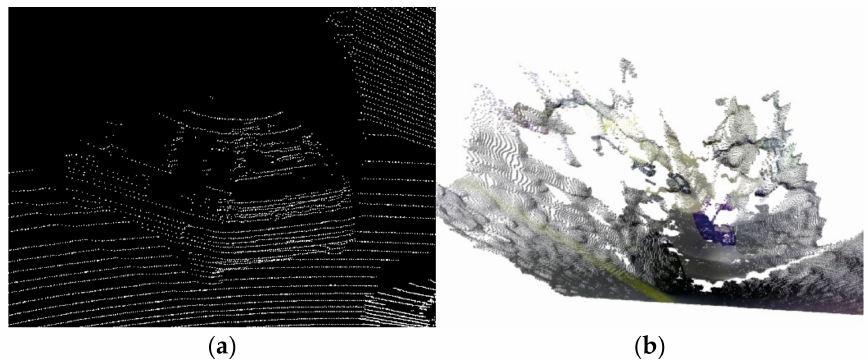
Figure 4. Comparison of point clouds. ( a ) Point cloud acquired with Velodyne HDL-64E LiDAR scanner provided in KITTI benchmark [52]. ( b ) Point cloud obtained from RealSense D455 (own data).